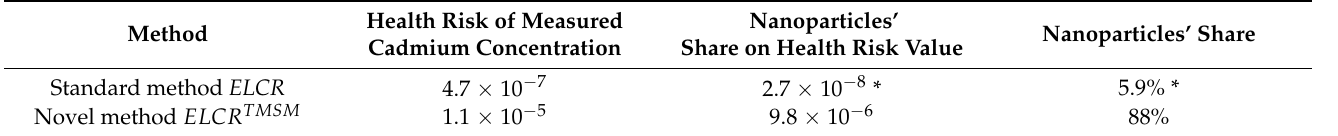
Table 4. Comparison of health risk calculation